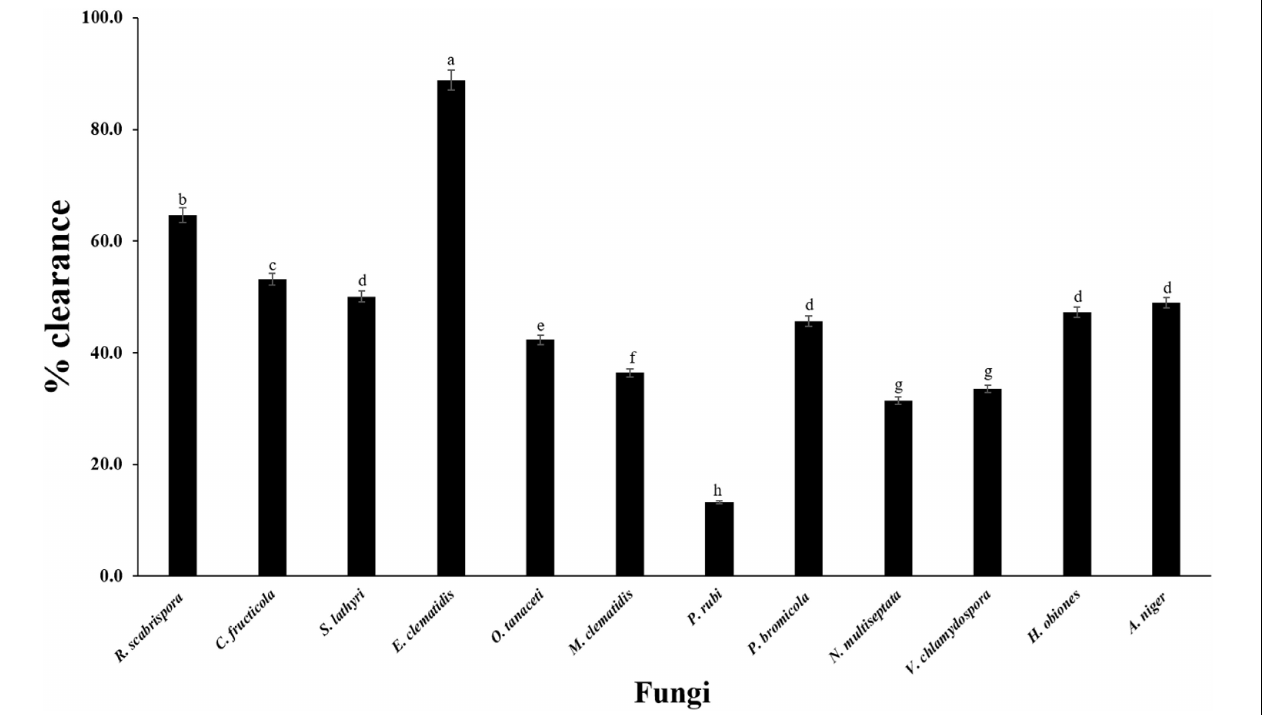
FIGURE 3 | Clearance percentage of culture supernantant of active fungi after 2-week inoculation. Different letters indicate significant differences ( p < 0.05) (ANOVA, followed by Duncan’s multiple range